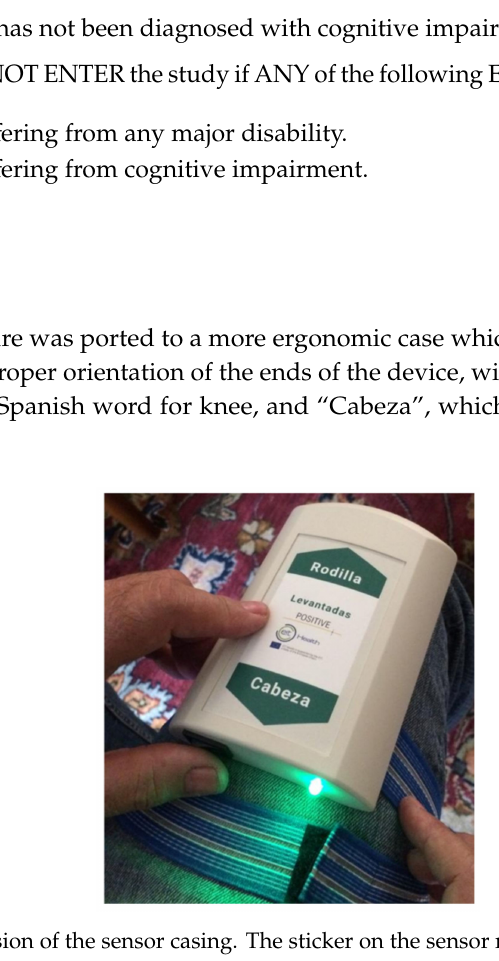
Figure 6. Second version of the sensor casing. The sticker on the sensor reports the correct orientation of the sensor with the help of two tags: “Rodilla”, which is the Spanish word for knee, and “Cabeza”, which is the Spanish word for